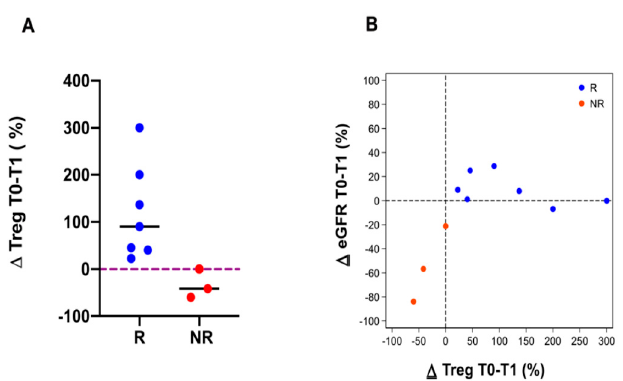
Figure 6. Immune cell subpopulations (CD3, CD4, CD8, NK, CD19 cells) were analyzed in all of the patients, except in one R patient and the dropout patients. The data are expressed as Δ percentage of the cells’ number before (T0) and after 1 year (T1) of ECP treatment( A , B ). Inversely, in the NR group the Th17 cells increased after 1 year of ECP